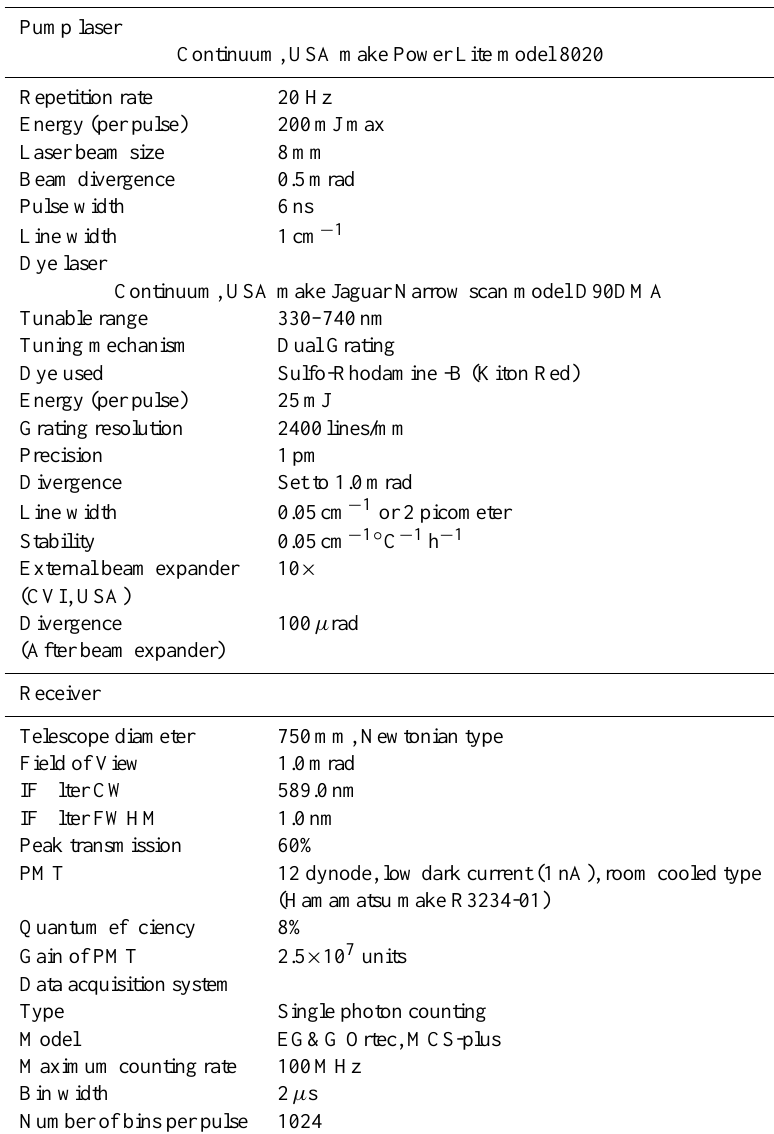
Table 1. Main specifications of sodium